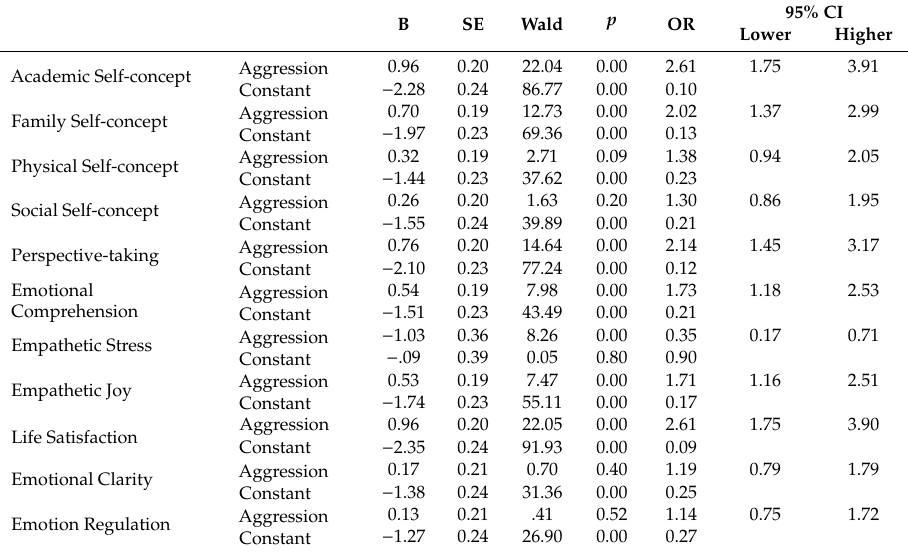
Table 3. Logistic regression with cyberaggression as a predictor of low scores.